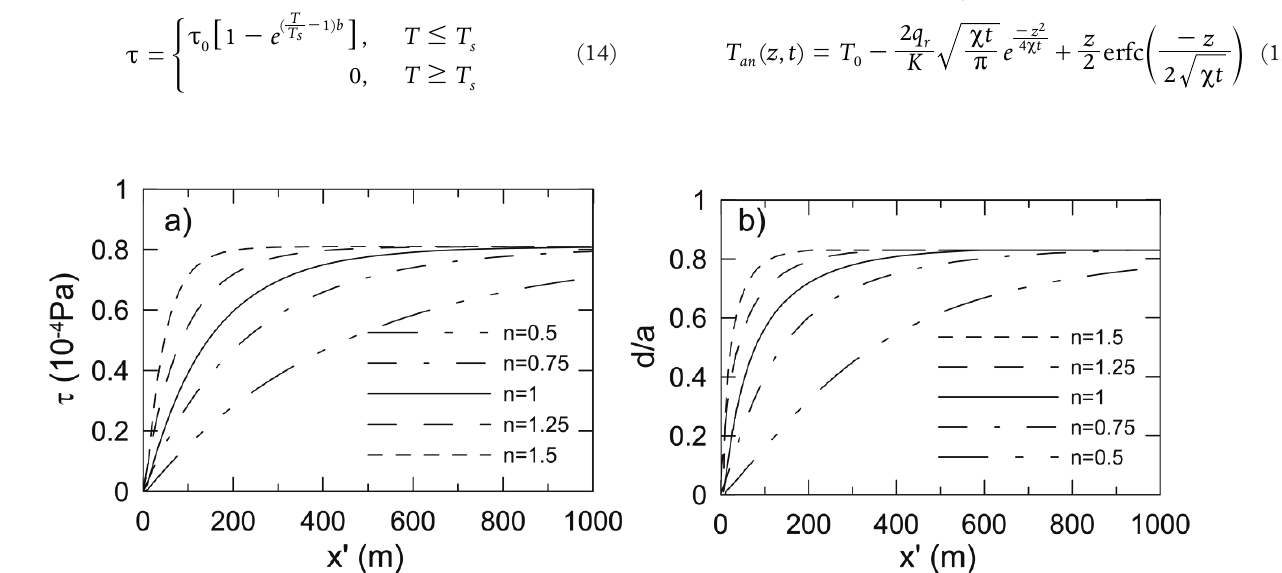
Figure 7. a) Yield strength x as a function of x ´ for different values of n . b) Crust coverage on the lava surface d / a as function of x ´ for different values of n ( a = 10 m, h = 3 m, a = 0.2 rad, t = 2800 kg m −3 , k = 10 4 Pa s n , c point on the flux direction where the surface temperature reaches the solidus, and it varies with varying n